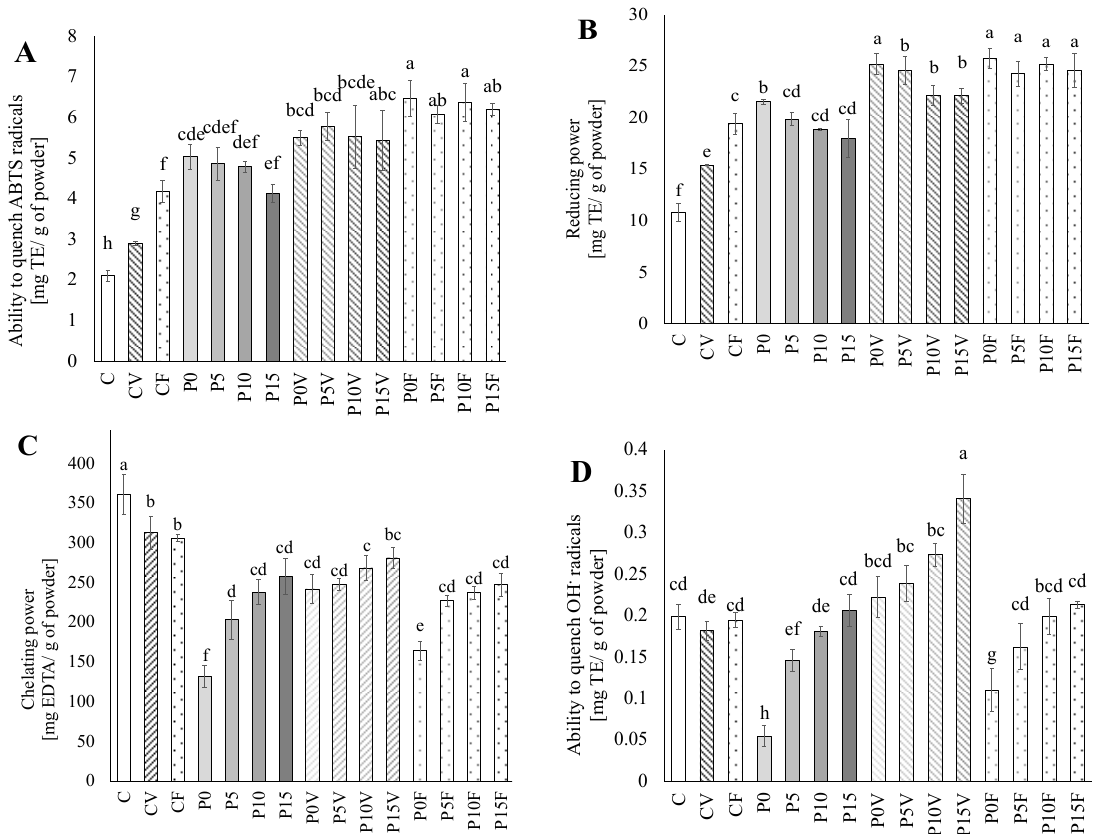
Figure 1. Antioxidant properties of powdered beverages. ( A )—Ability to quench ABTS radicals; ( B )—Reducing power; ( C )—Chelating power; ( D )—Ability to quench OH-radicals. C—beverages based on lentil sprouts; P—beverages based on lentil proteins; V—lyophilized parsley and broccoli sprouts; F—lyophilized strawberry and raspberry; 0–15—percent of flaxseeds gum. Means in each